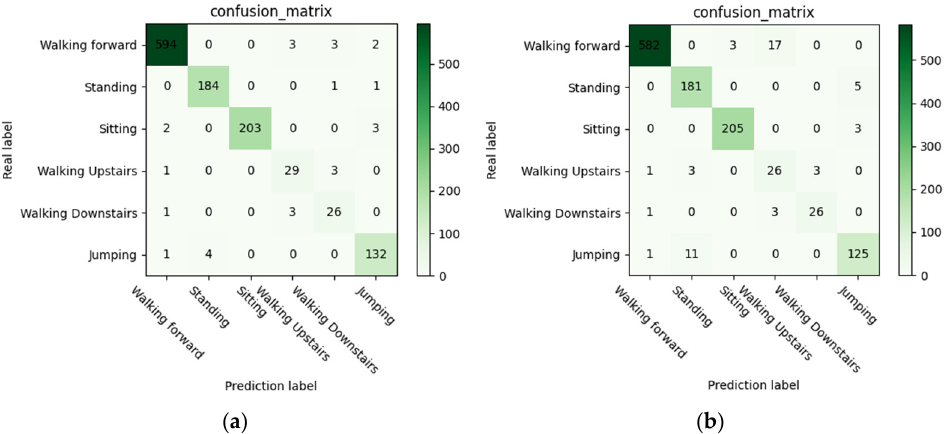
Figure 9. Confusion matrix obtained for inertial sensors ( a ) and stretch sensors ( b ) on the w-HAR dataset.